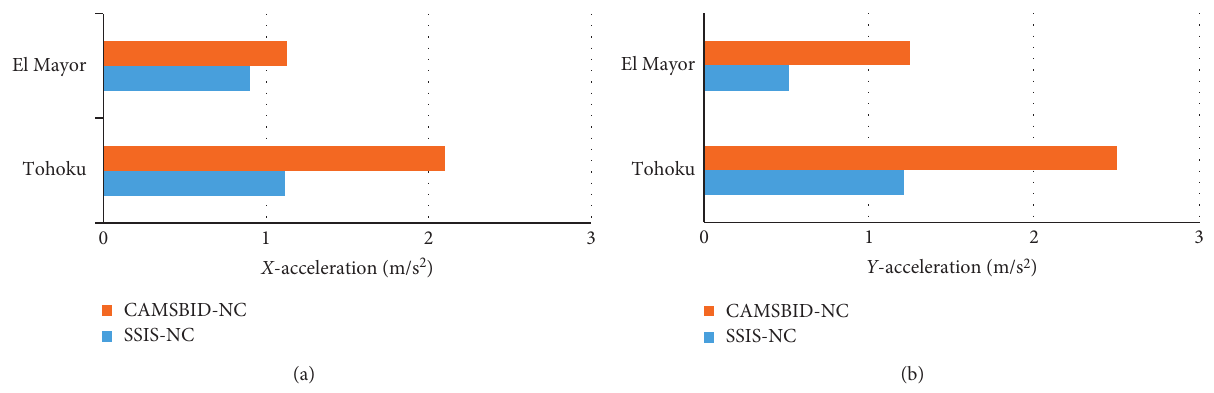
Figure 16: Peak base-level acceleration responses of SSIS-NC and CAMSBID-NC structures.